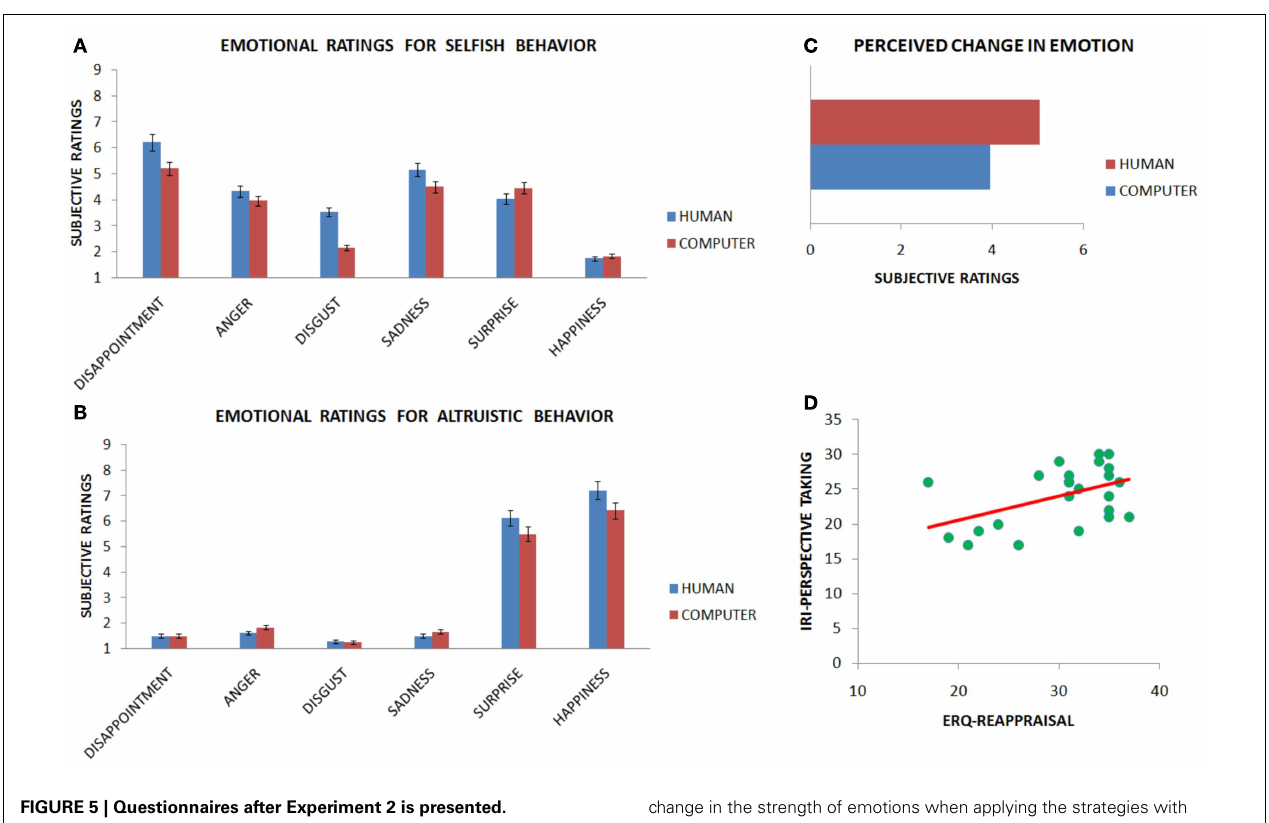
FIGURE 5 | Questionnaires after Experiment 2 is presented. Subjects were more disappointed and disgusted when observing a selfish behavior (1C offer) from human rather than computer partners (A) .When receiving altruistic offer (5C offer) subjects were happier when the donator was a human partner (B) . Subjects perceived a